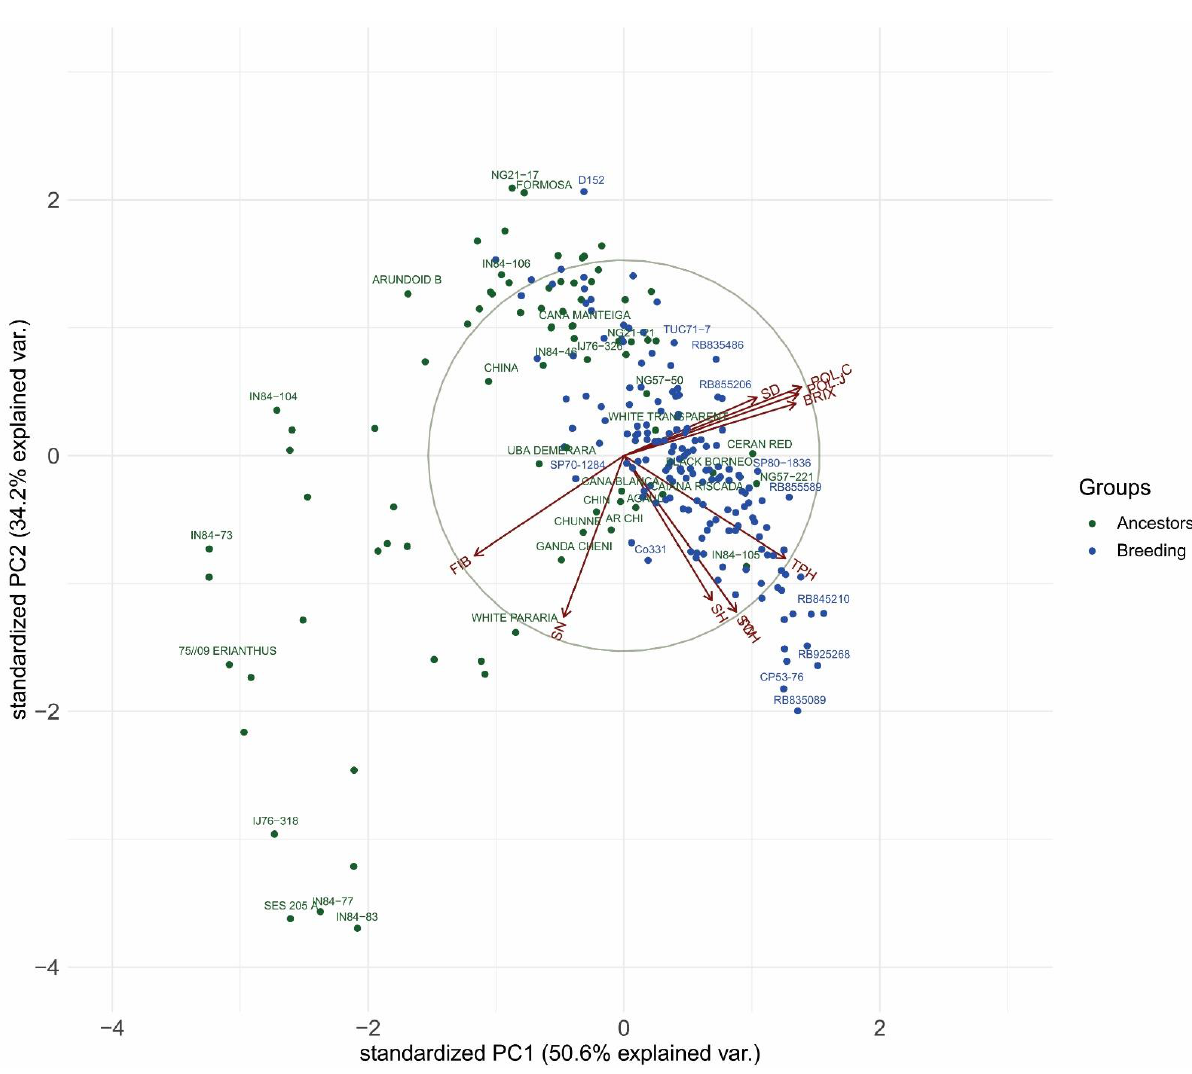
Figure 2. Biplot analysis of the accessions of Brazilian Panel of Sugarcane Genotypes (BPSG) considering adjusted means of three harvest years (2014, 2015, and 2016) for BRIX (in °Brix), sucrose content of the cane (POL%C, in %), sucrose content of the juice (POL%J, in %), fiber content (FIB, in %), stalk height (SH, in m), stalk number (SN), stalk diameter (SD, in mm), stalk weight of the plot (SW, in kg), cane yield (TCH, in t/ha) and sucrose yield (TPH, in t/ha). Ancestors and breeding accessions are in green and blue, respectively. Figure 3 indicates the distribution of genotypic means considering the subset struc- tures for all evaluated traits. Considering the boxplot ranges and medians, it is possible to compare the ancestor group (A) with the Brazilian breeding germplasm (from B1 to B6). In general, the boxplot range indicated a large variability from ancestors when compared with Brazilian subsets, except for TPH. This variability can be detailed, i.e., for FIB and SN the larger variation was an increase in the trait values; SD and SH indicated variability for both sides of selection; and sucrose-related traits (BRIX, POL%C, and POL%J) showed variability related to accessions with reduced sugar yield. The only ancestor group